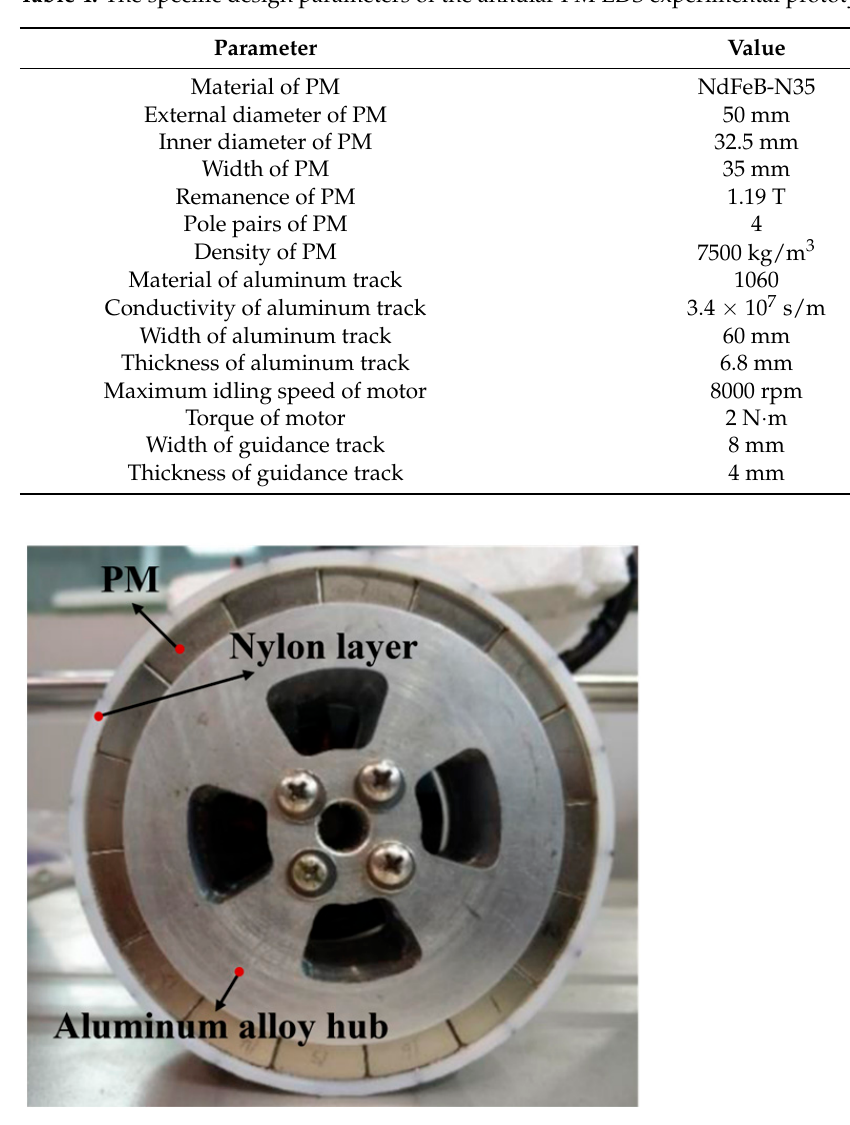
Figure 19. Physical picture of the equivalent rotating PM wheel.